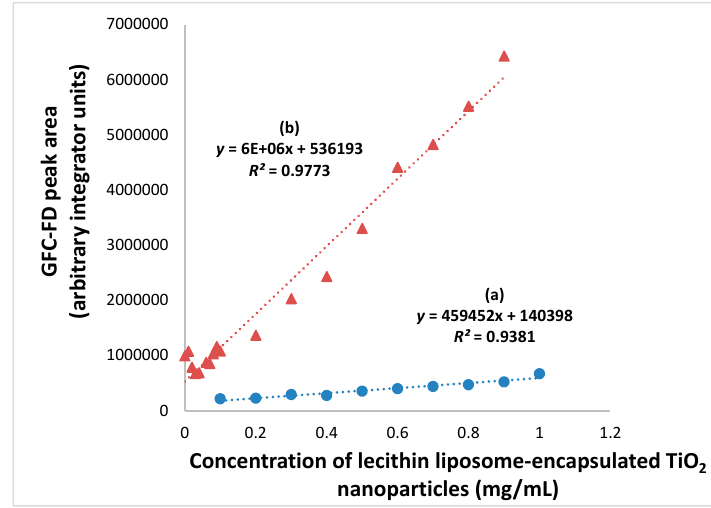
Figure 6. Standard calibration curves for rapid GFC analysis of lecithin liposome-encapsulated TiO 2 nanoparticles using ( a ) λ ex = 365 nm and λ em = 460 nm, and ( b ) λ ex,max = 350 nm and λ em,max = 395 nm, for FD.